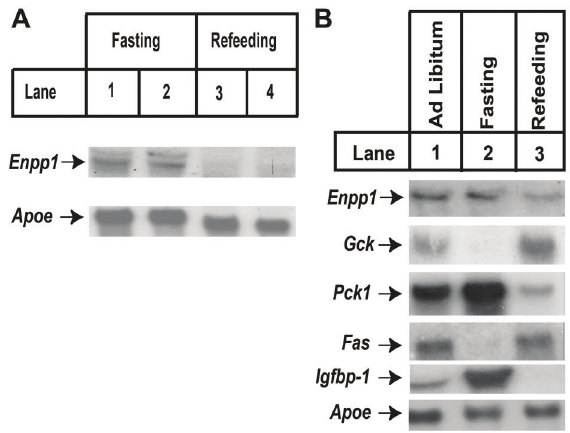
Figure 1. Expression levels of Enpp1 , Gck , Pck1 , Fas, Igfbp-1 , and Apoe transcripts in the liver of rats in the cycle of fasting and refeeding. A , mRNA of Enpp1 and Apoe in the liver of rats (2 in each group) fasted for 48 h or refed for 12 h after a 36-h fasting. B , mRNA levels of Enpp1 , Gck , Pck1 , Fas, Igfbp-1 , and Apoe in the liver of rats (5 rats per group) fed ad libitum , fasted for 48 h or refed for 12 h after a 36-h fasting. Total liver RNA pooled from rats in each group was isolated and subjected to northern blot analysis. Enpp1 : Ectonucleotide pyrophosphatase/phosphodies- terase 1 gene; Apoe : apolipoprotein E gene; Gck : glucokinase gene; Pck1 : the cytosolic form of phosphoenolpyruvate carboxy- kinase gene; Fas : fatty acid synthase gene; Igfbp-1 : insulin-like growth factor-binding protein